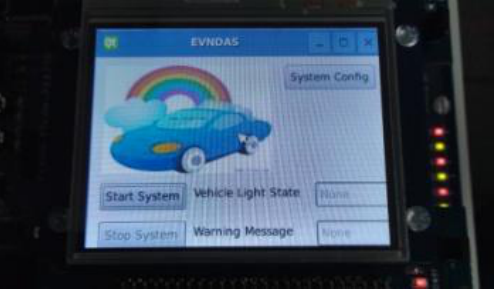
Figure 16. The user interface of the proposed VIDASS